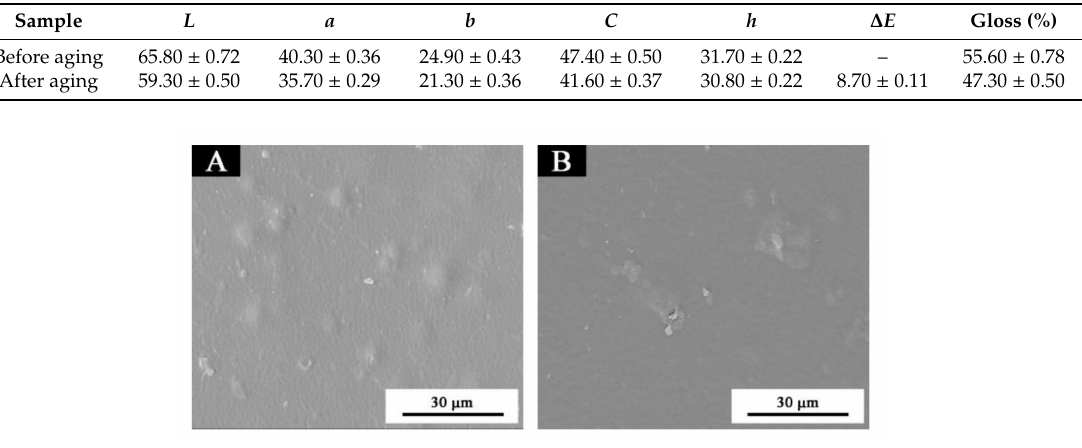
Figure 13. SEM of waterborne wood coatings with three-layer primer, three-layer topcoat, and thermochromic ink added to the topcoat: ( A ) before and ( B ) after